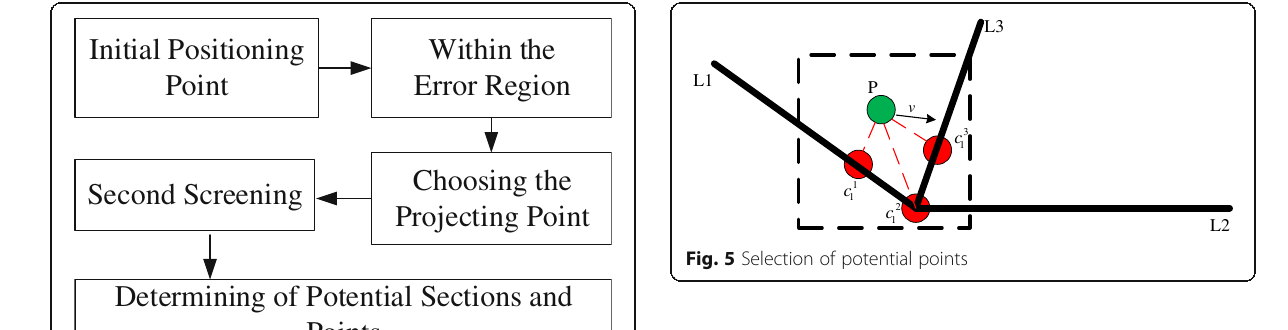
30°, L3 will be rejected from the potential sections. The final potential sections of point P are L1 and L2 , and the corresponding matching points are c 1 ively. With the secondary screening, the invalid potential